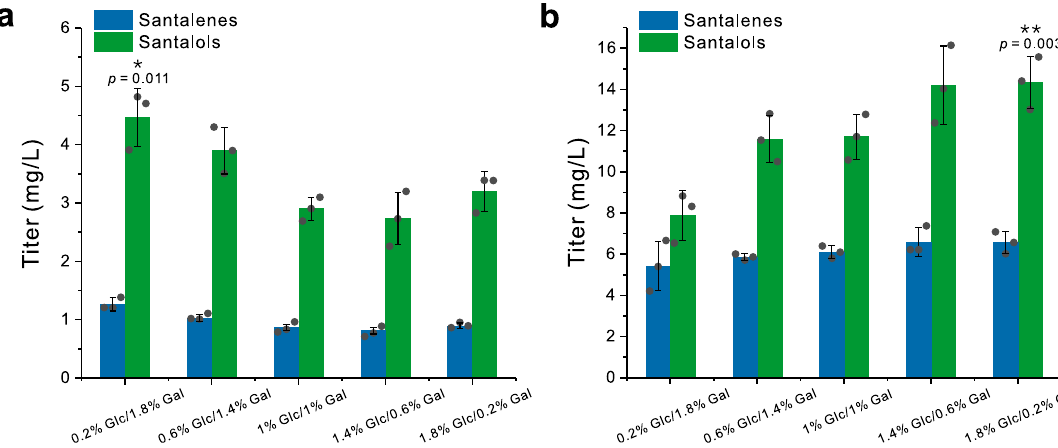
Fig. 6 The titers of santalenes and santalols in SZ21 and SZ22. The titers of santalenes and santalols in SZ21 (with two copies of SanSyn F441V and one copy of tHMG1 and CYP736A167 ) ( a ) and SZ22 (with three copies of SanSyn F441V and two copies of tHMG1 and CYP736A167 ) ( b ) when fermented with the different ratios of glucose and galactose. All data represent the mean of n = 3 biologically independent samples and error bars show the standard deviation. Statistical analysis was performed by using two-tailed and two-sample unequal variance t test (* P < 0.05, ** P < 0.01). Source data are provided as a Source Data fi le.